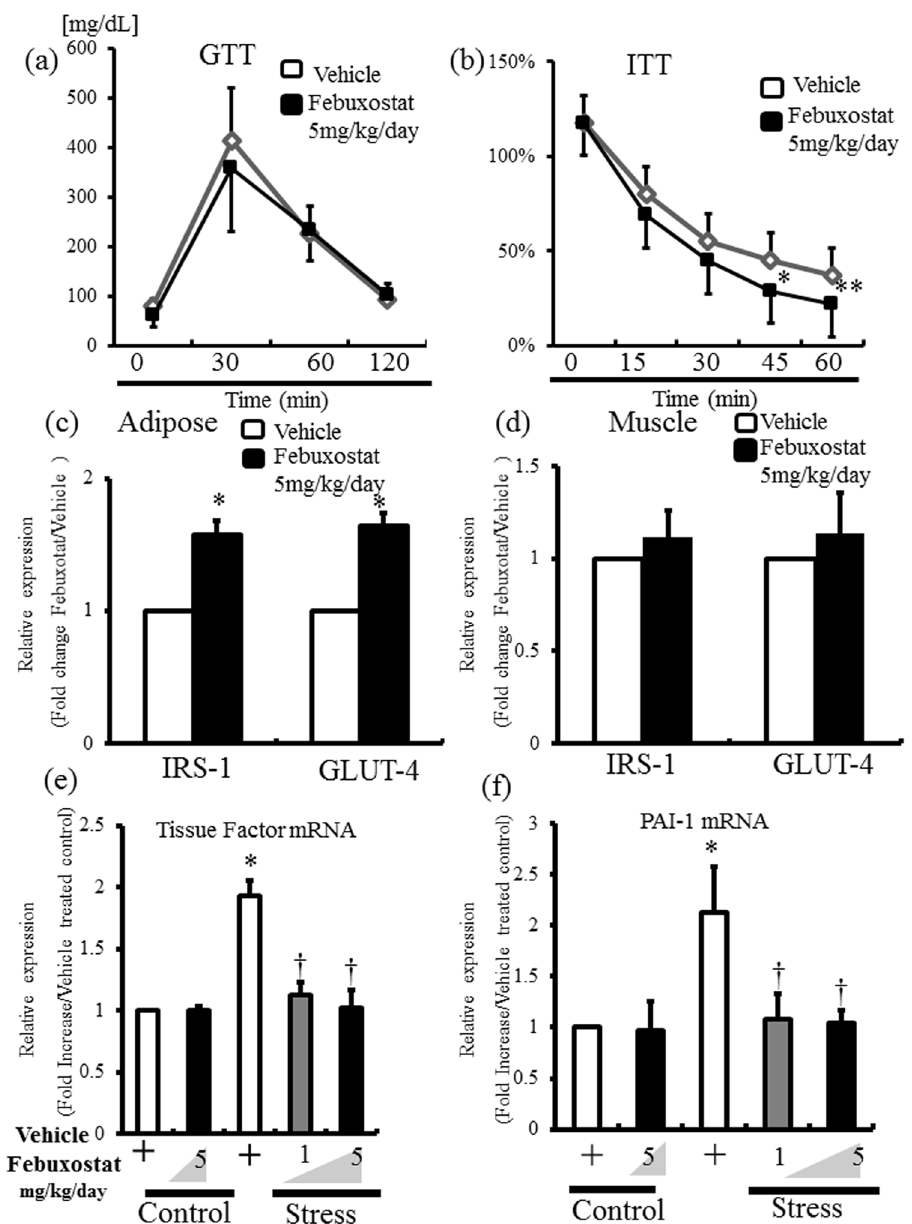
Figure 9. Febuxostat improves stress-induced insulin resistance and prothrombotic state. After two weeks of daily stress, intraperitoneal glucose tolerance (GTT) and insulin tolerance tests (ITT) were performed in the vehicle- and febuxostat- (5 mg/kg/day) treated mice. The mRNA expression levels of IRS-1 and GLUT4, in inguinal adipose tissue and skeletal muscle (adductor muscle), and PAI-1 and tissue factor in inguinal adipose tissue were analyzed by quantitative RT-PCR. Data were analyzed by Student’s t-test and displayed as mean ± SD of 8 mice per group. ( a ) Glucose tolerance was comparable between the stressed mice treated with vehicle and febuxostat after stress. ( b ) Insulin tolerance showed significant recovery in febuxostat-treated and stressed mice. * P < 0.05, and ** P < 0.04, compared with the vehicle-treated and stressed mice. ( c , d ) Quantitative analysis of IRS-1 and GLUT4 expression levels in inguinal adipose tissue ( c ) and skeletal muscle (adductor muscle) ( d ) of stressed mice treated with vehicle or febuxostat (5 mg/kg/day). * P < 0.001, compared with vehicle-treated and stressed mice. ( e , f ) Quantitative analysis of tissue factor and PAI-1 expression in inguinal adipose tissue of the control and stressed mice treated with vehicle or febuxostat (1 or 5 mg/kg/day). * P < 0.001, compared with vehicle-treated control mice, † P < 0.001, compared with vehicle-treated stressed